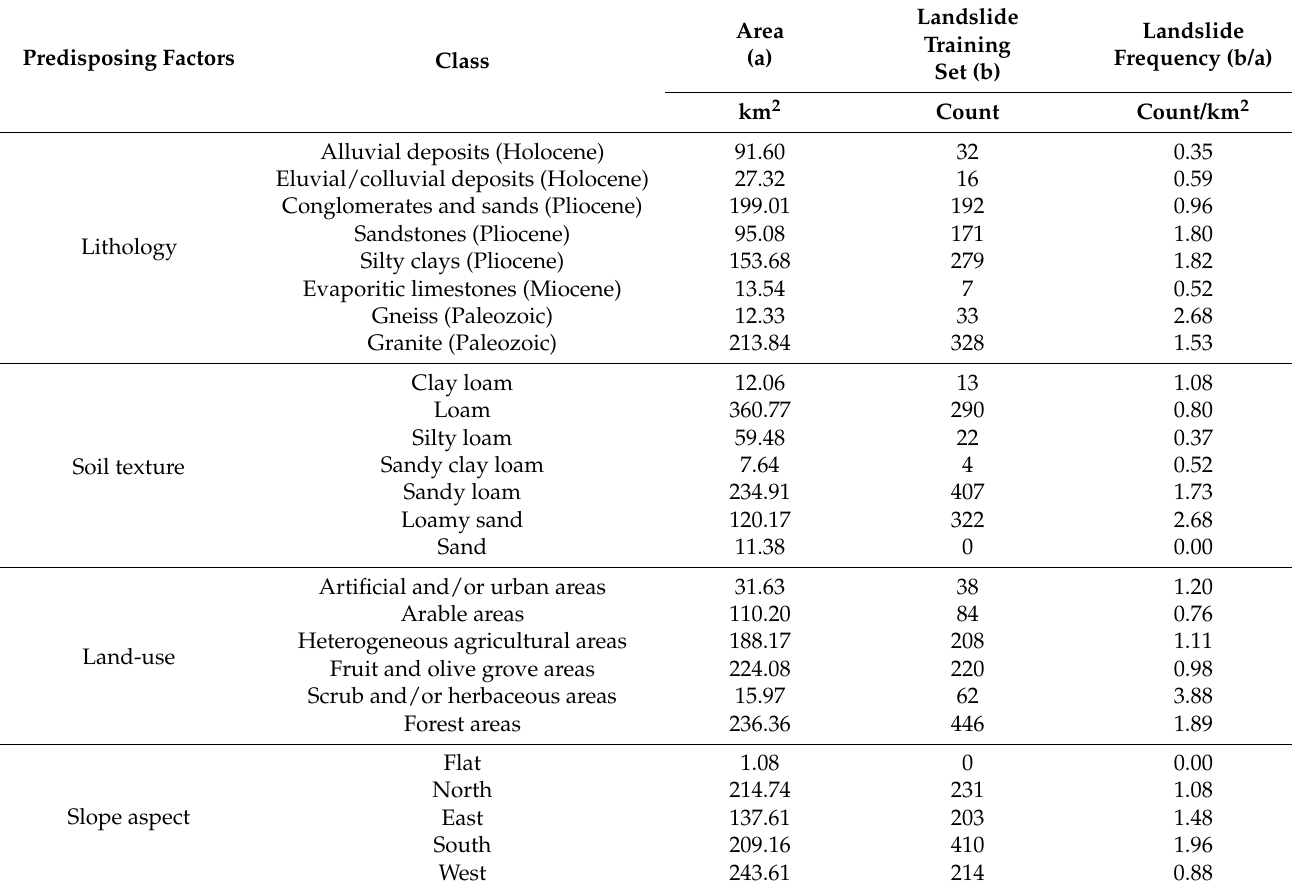
Table 3. Categorical predisposing factors and related landslide frequency values used in the logistic regression analysis.